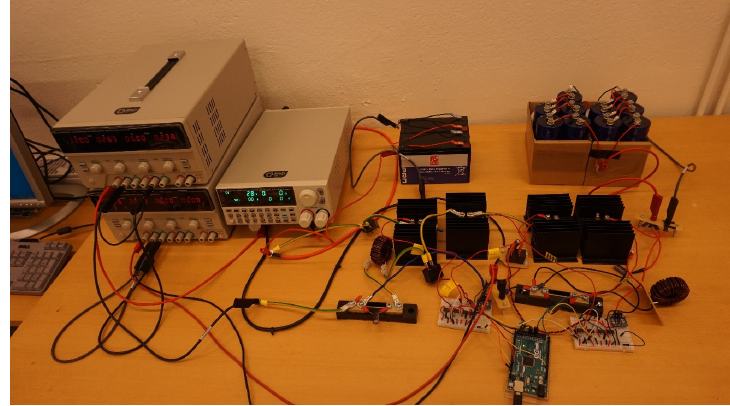
Figure 11. HESS experimental setup.